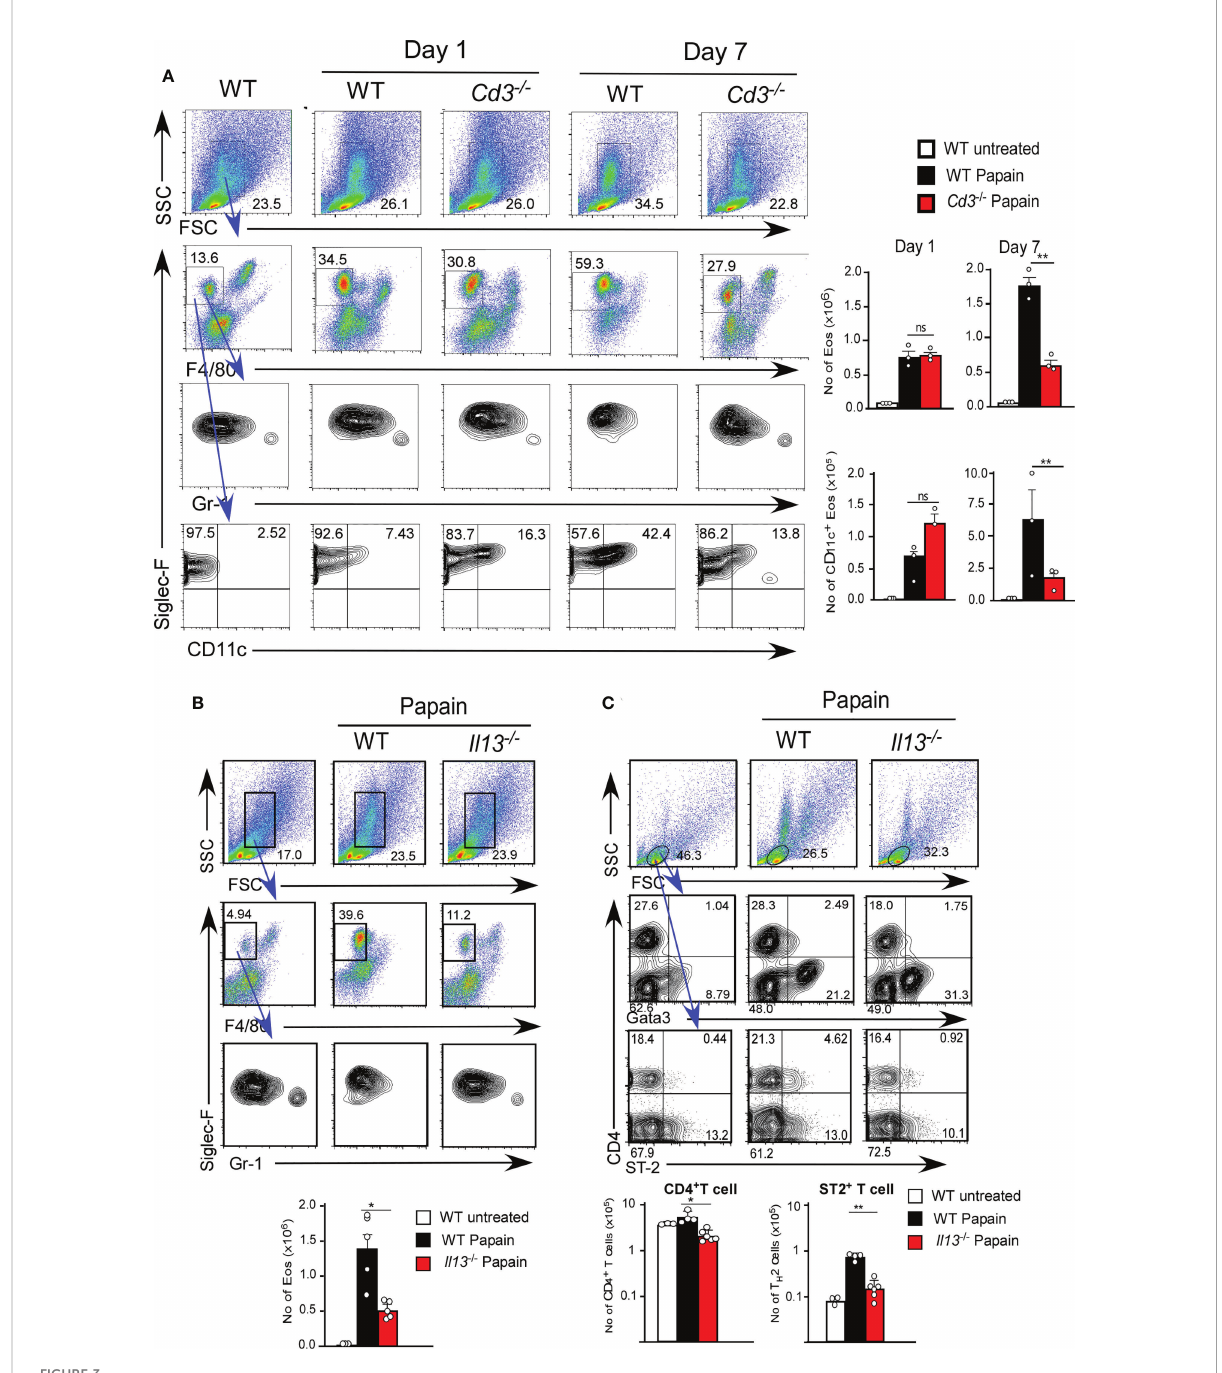
FIGURE 3 (A) Cd3-suf fi cient (WT, n=3) or -de fi cient (n=3) mice were administrated with papain. Lung cells were harvested on day one or seven after the fi nal papain injection, and the proportions and cell numbers of Eos and T cells were assessed. (B, C) Il13-suf fi cient (WT, n=5) or -de fi cient (n=5) mice were administrated with papain. The proportions (left fl ow pro fi les) and numbers (right graphs) of Eos (B) and ST-2+CD4+ T cells (C) were assessed at seven days. Bars represent the means; not signi fi cant (ns), *p – 0.05, **p – 0.01 using unpaired Mann-Whitney U-tests. All error bars represent the SEM. Data are representative of three (A, B) or two (C)